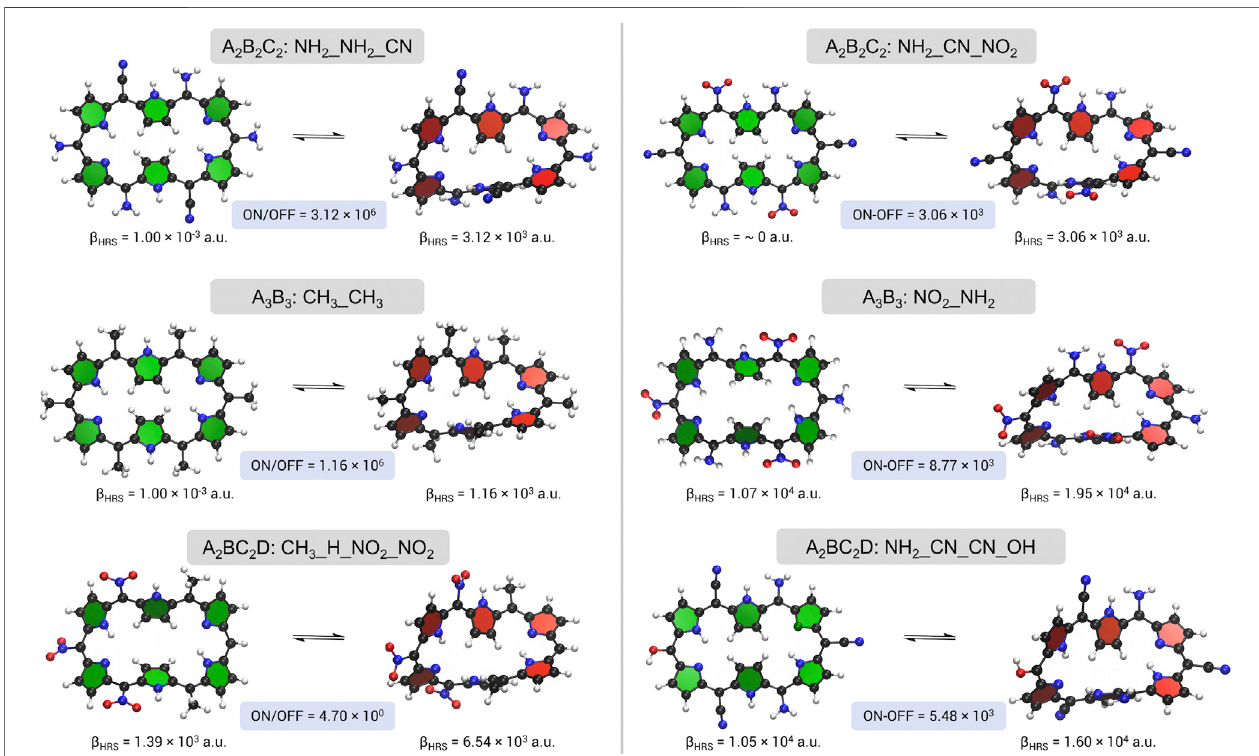
FIGURE 7 | A schematic overview of the topological switches with the highest NLO contrast, β HRS ratio on the left and β HRS difference on the right, upon meso - substitution for the three substitution patterns.